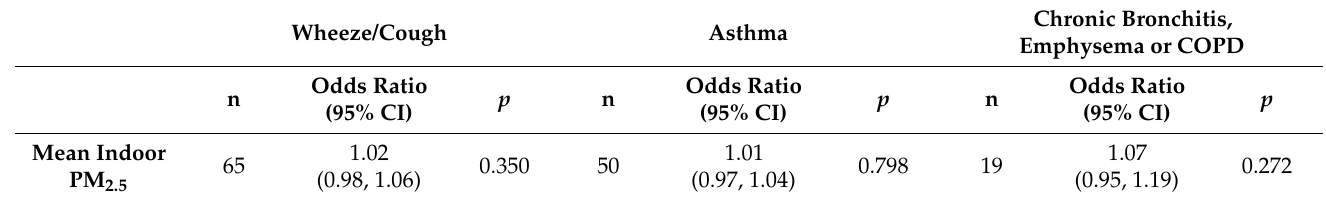
Table 4. Odds ratio for mean indoor PM 2.5 and respiratory outcomes.